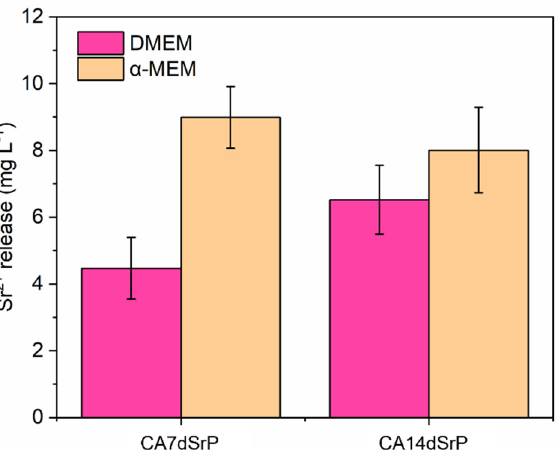
Figure 8. The total amount of Sr 2+ dissolved in the culture media in the absence of cells after 24 h of exposure to CA7dSrP and CA14dSrP.